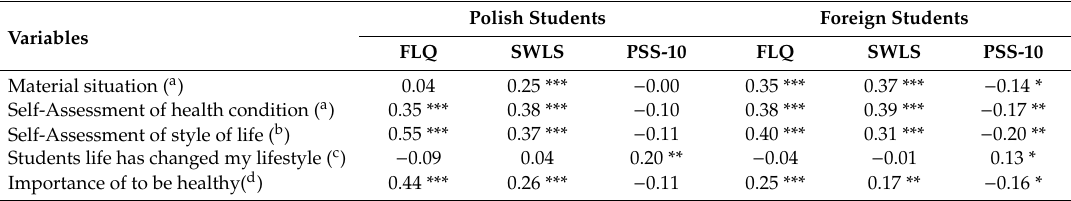
Table 2. Students’ self-assessment regarding health and lifestyle vs. FLQ, SWLS and PSS-10.